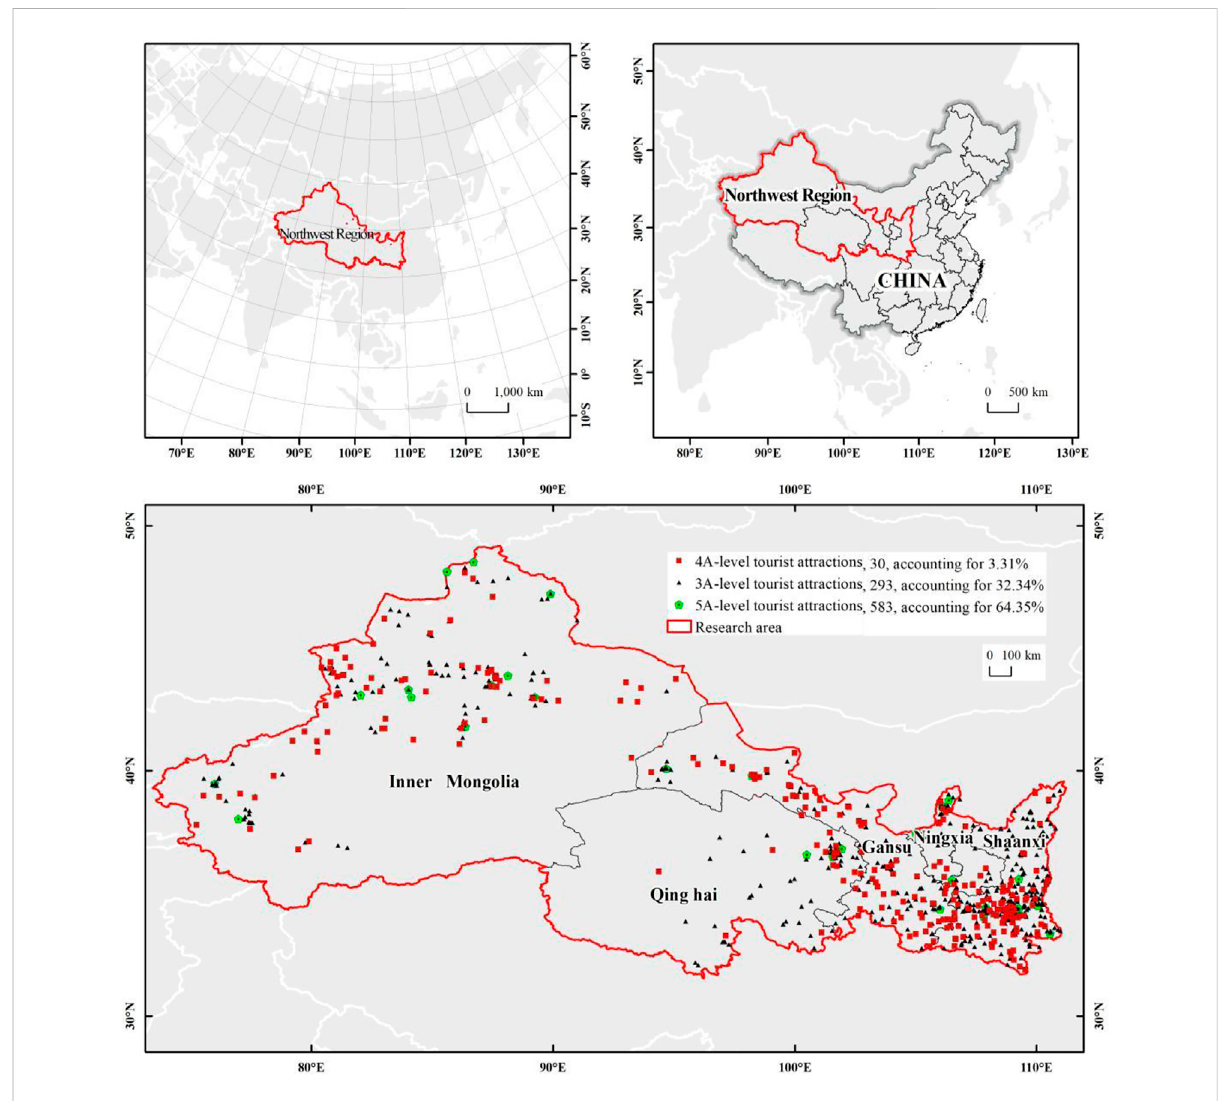
FIGURE 1 Spatial distribution of 3A-level and above scenic spots in Northwest